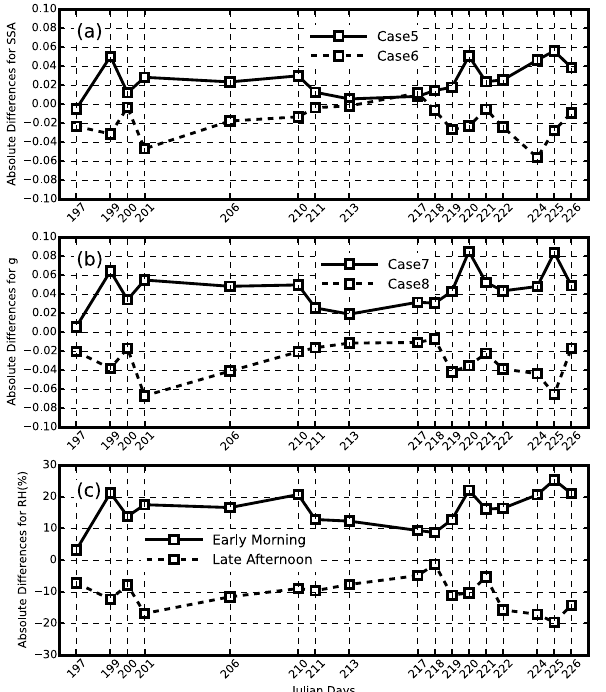
Figure 6. The absolute differences between early morning (or late afternoon) average and the daytime average of SSA, g , and RH. (a) for SSA: corresponding to cases 5 and 6; (b) for g : correspond- ing to cases 7 and 8; (c) for RH.